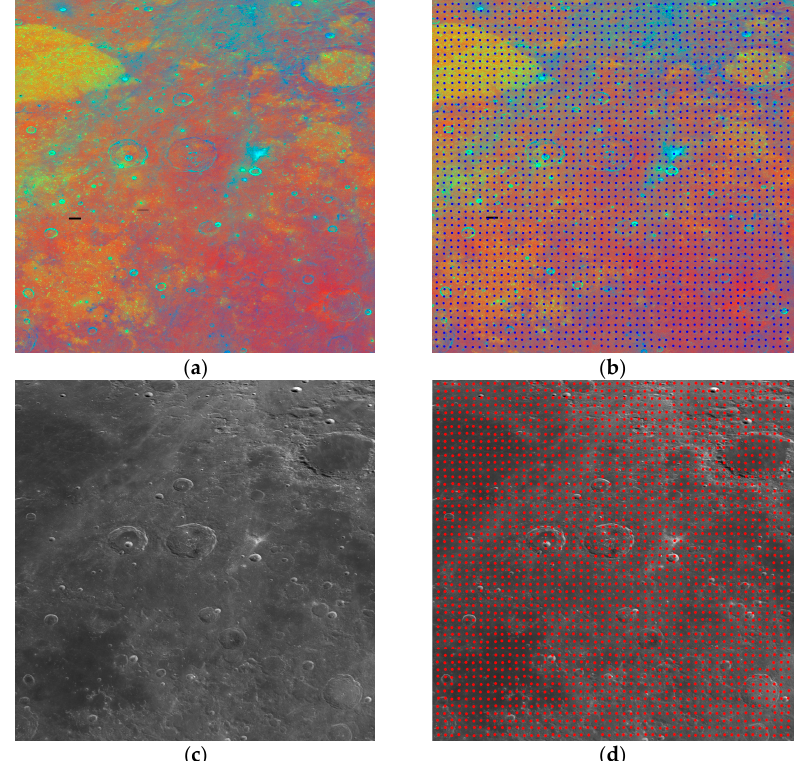
Figure 3. Examples of matching result of a 30° × 30° image block centered at (45°E, 45°N). ( a ) Clementine UVVIS Warped Color Ratio Mosaic 200 m; ( b ) final control points (Clementine UVVIS Warped Color Ratio Mosaic 200 m); ( c ) CE1_TMap_GDOM_120m; ( d ) final control points (CE1_TMap_GDOM_120m).